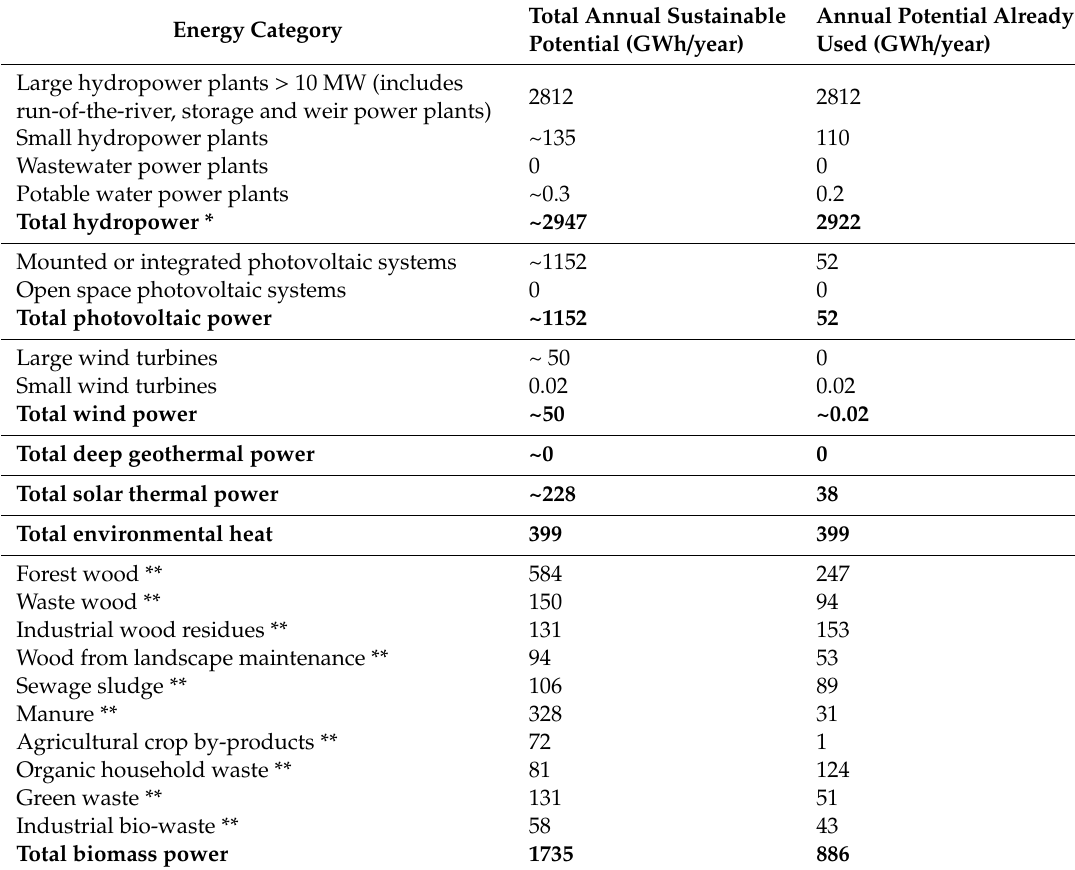
Table 1. Total potential available and the potential of electricity and heat generation from renewable energies already used in the canton of